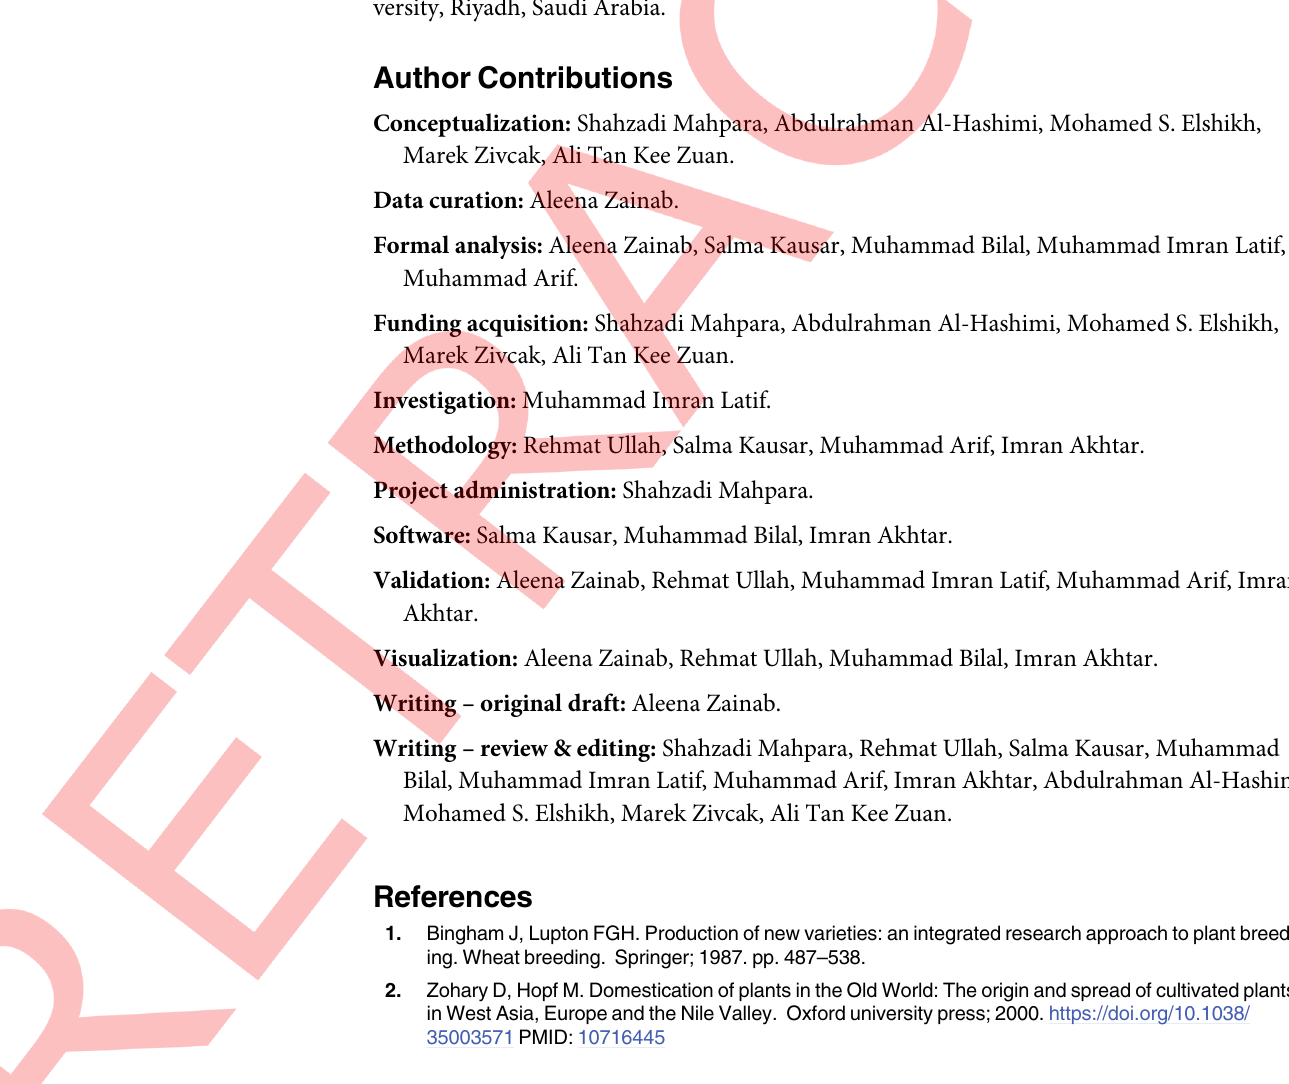
S1 Table. Analysis of variance for seed germination percentage and growth traits of differ- ent wheat genotypes grown under various PEG-induced drought stress levels. S2 Table. Analysis of variance for percentage decrease in seed germination percentage and growth traits of different wheat genotypes grown under various PEG-induced drought stress levels. S3 Table. Minimal dataset used in the study to build graphs and perform statistical analy-